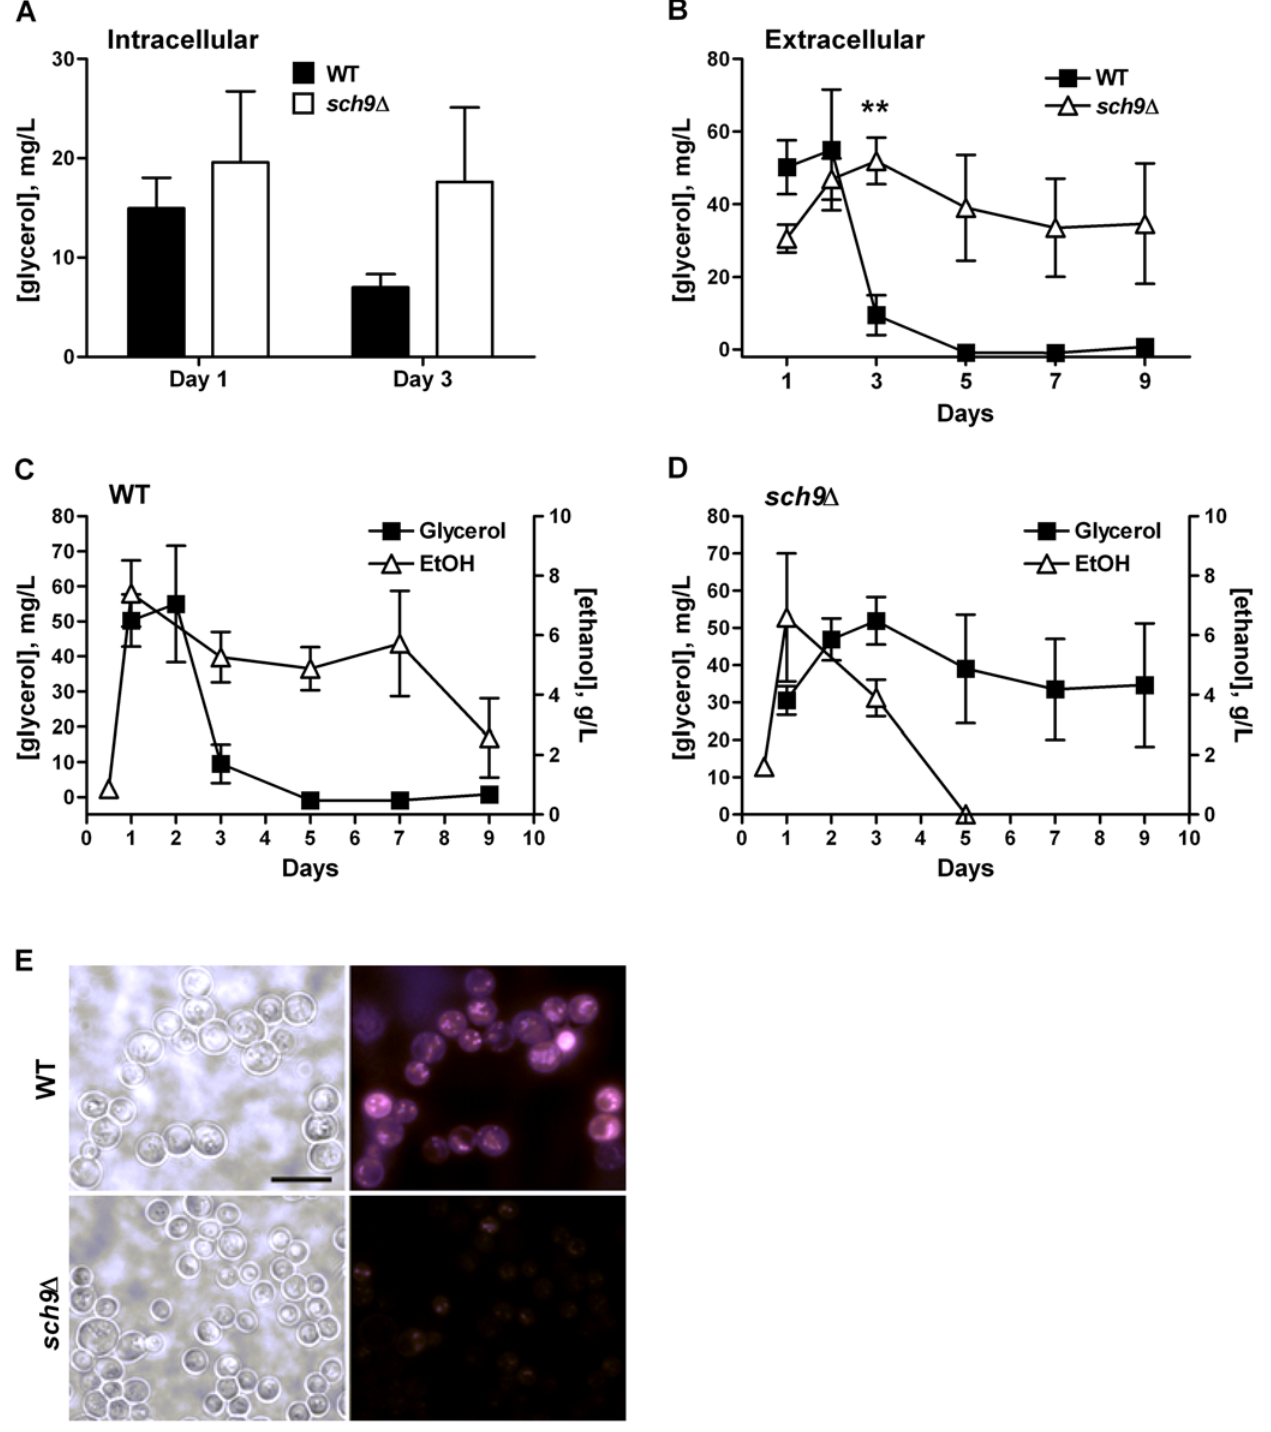
Figure 4. Sch9 deficient mutants metabolize ethanol and accumulate glycerol. (A) Intracellular glycerol contents of wild type (DBY746) and cells lacking Sch9 were measured on day 1 and day 3. Data represent mean and SEM of 8 cultures analyzed. (B) Glycerol concentration in the medium of wild type and sch9 D cultures. Data represent mean and SEM of 5–7 cultures analyzed. ** p , 0.01, unpaired t -test, two-tailed, sch9 D vs. WT. (C–D) Glycerol and ethanol concentrations in the medium of wild type (C) and sch9 D (D) cultures. Data represent mean and SEM of 3–5 cultures analyzed. (E) Nile red staining of neutral lipids of day 1 wild type and sch9 D mutants. Nile red staining is shown on the right, and phase contrast left. Bar, 10 m m.